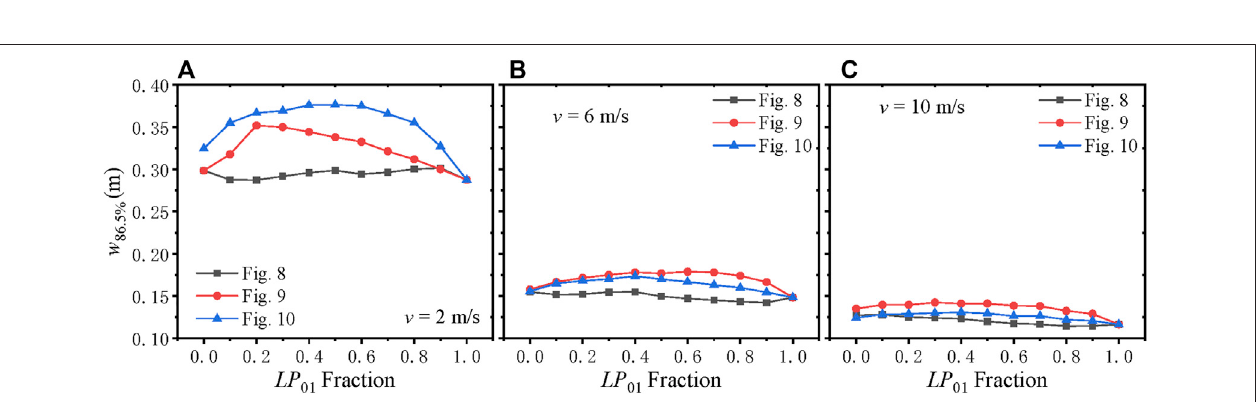
FIGURE 10 | Variation of beam width w 86.5% with LP 01 fraction for different values of wind speeds.